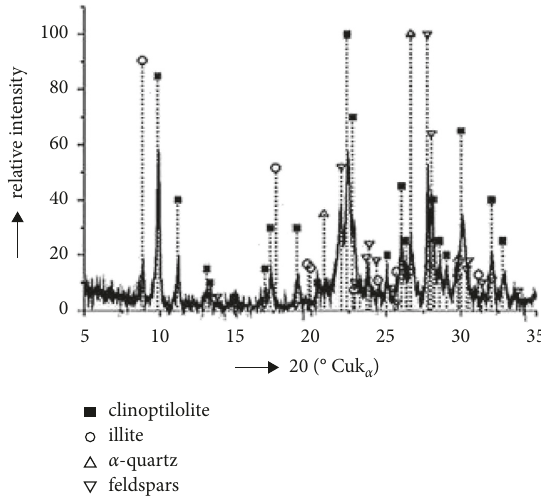
Figure 1: XRD of NZ from Donje Jesenje site, Croatia [27]. Table 1: Chemical compositions of OPC and NZ from Donje Jesenje site.